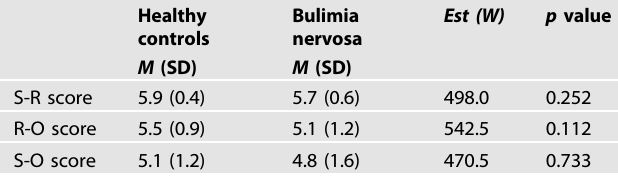
Table 2. Explicit stimulus-response-outcome